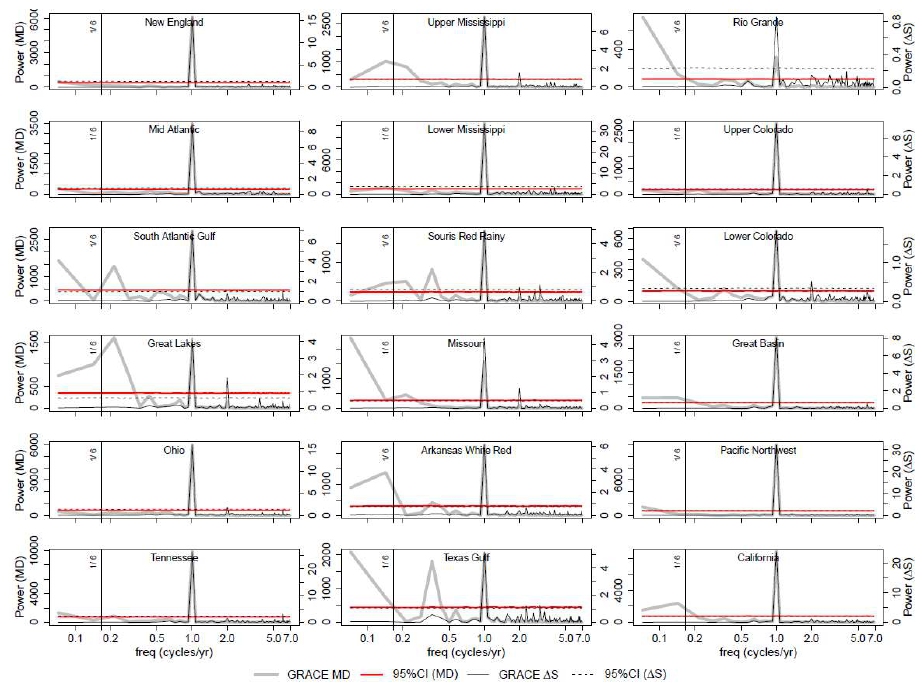
Figure 4. Scaled periodograms of basin-average spectra for GRACE TWSA (grey line) and GRACE ΔS (black line) derived for the surface basins. The red and the dashed black lines are the 95% confidence intervals for TWSA and ΔS, respectively.